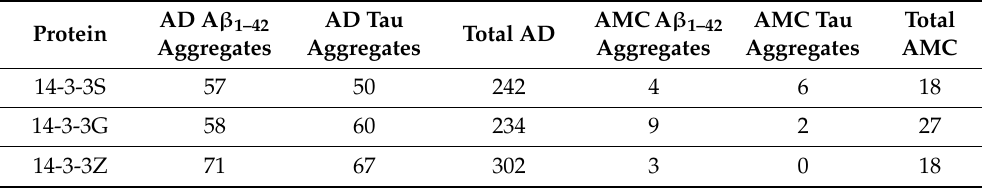
Table 1. Spectral hits for three paralogs of 14-3-3 in AD and AMC aggregates, isolated by